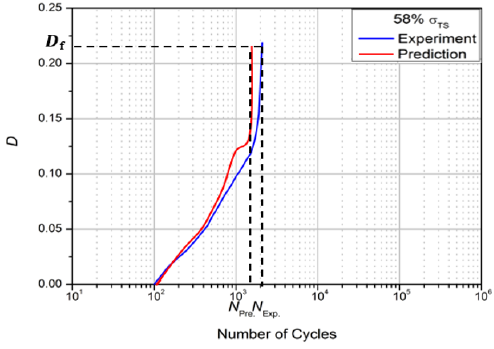
D , between the predicted life and the experimental data per cycle.